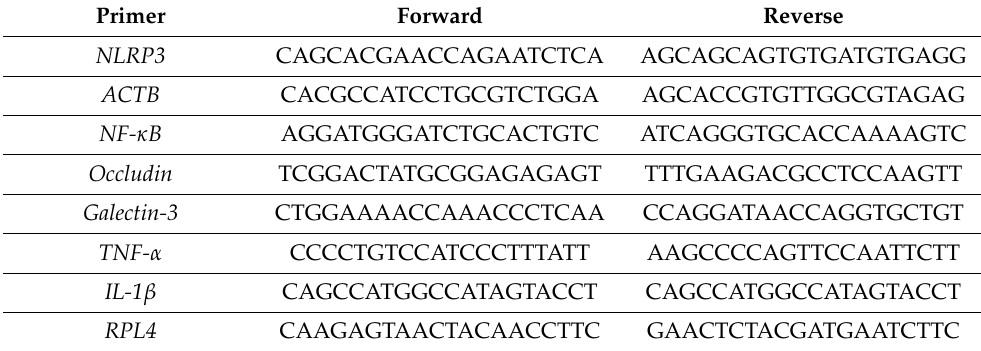
Table 2. Primer pairs in 5 (cid:48) -3 (cid:48) directions used for a quantitative real-time PCR.